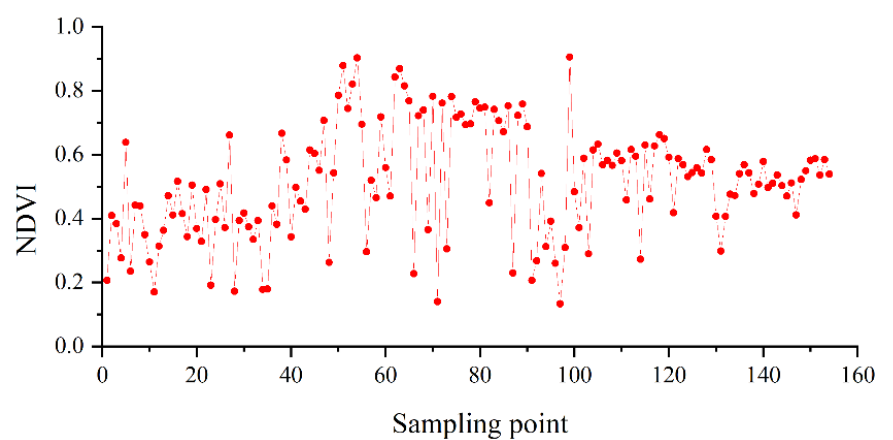
Figure 4. Normalized vegetation index (NDVI) values in sampling points.